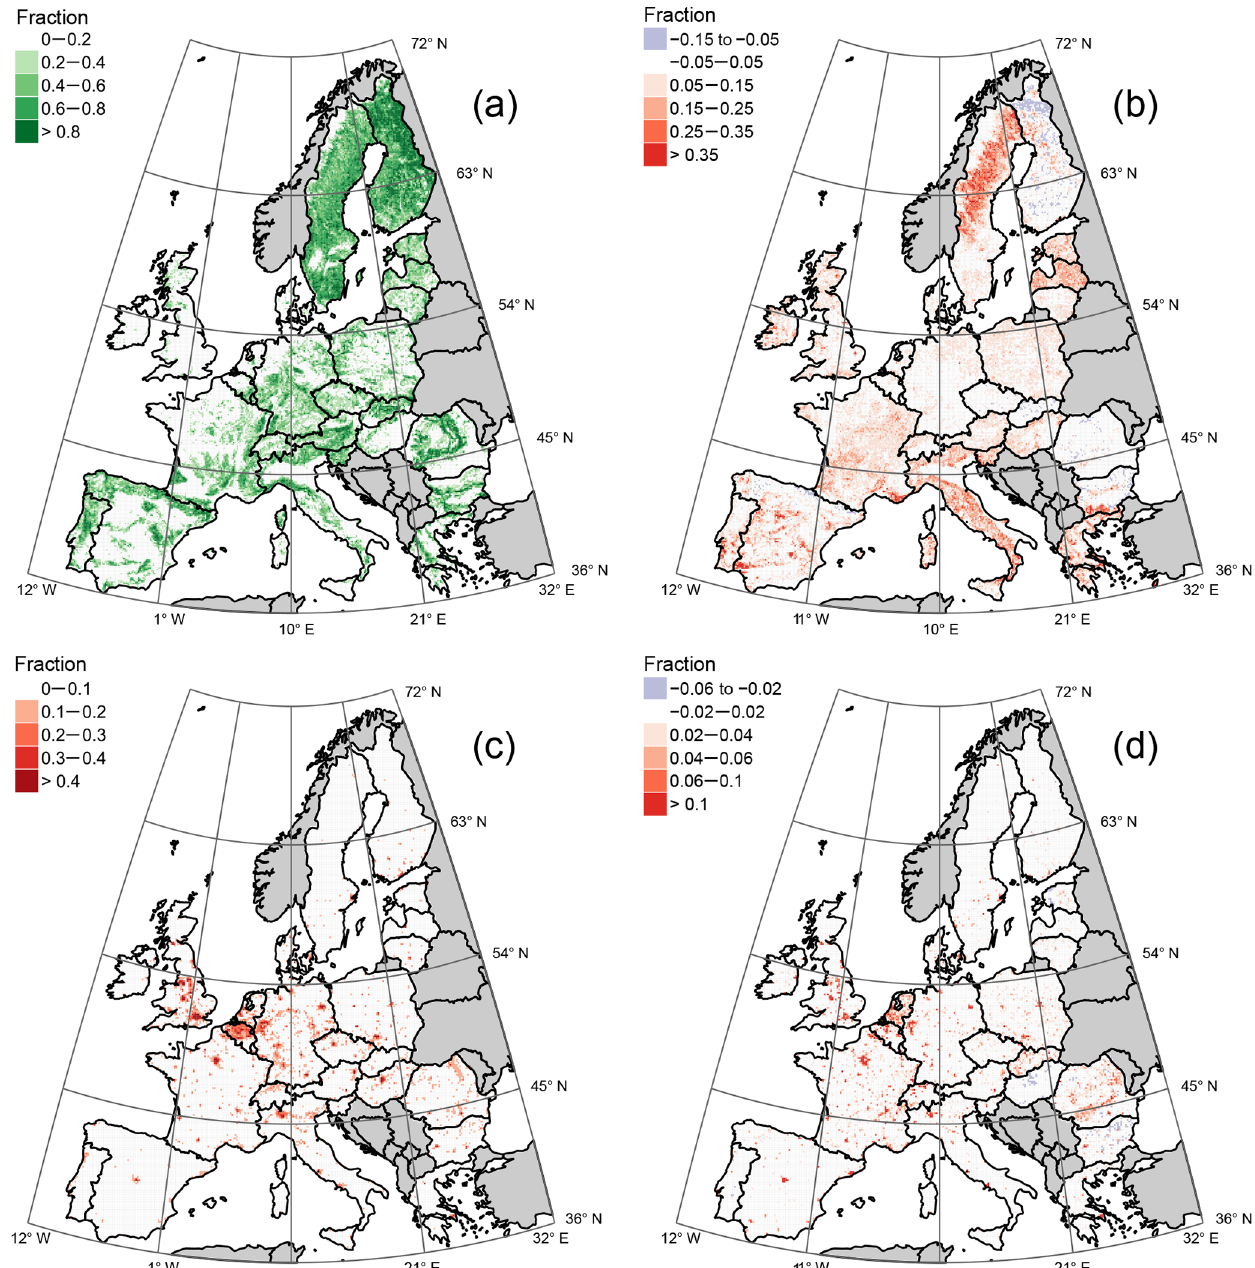
Figure 3. Land cover characteristics over the period 1960–2010. Left panels show the mean forest cover and urban fraction in 1960 ( a and c , respectively), while the right panels indicate the change between the periods 1960 and 2010 for forest cover (b) and urban area (d)